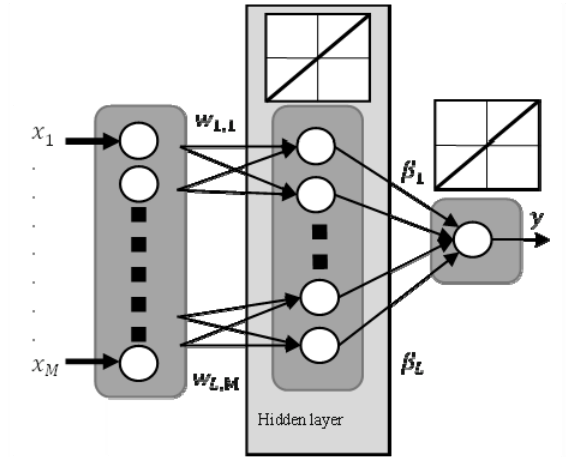
Figure 2. RELM for